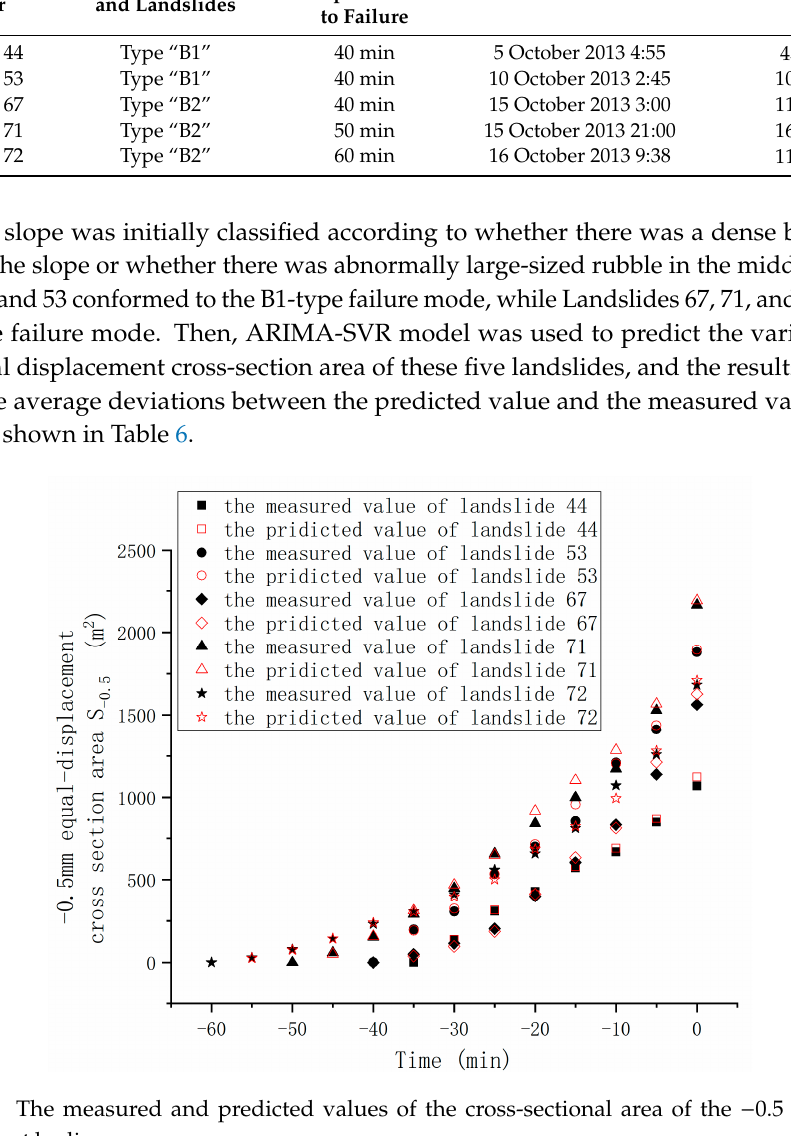
Figure 12. The measured and predicted values of the cross-sectional area of the − 0.5 mm equal displacement bodies. Table 6. The average deviations between the predicted value and the measured value of the five test landslides.